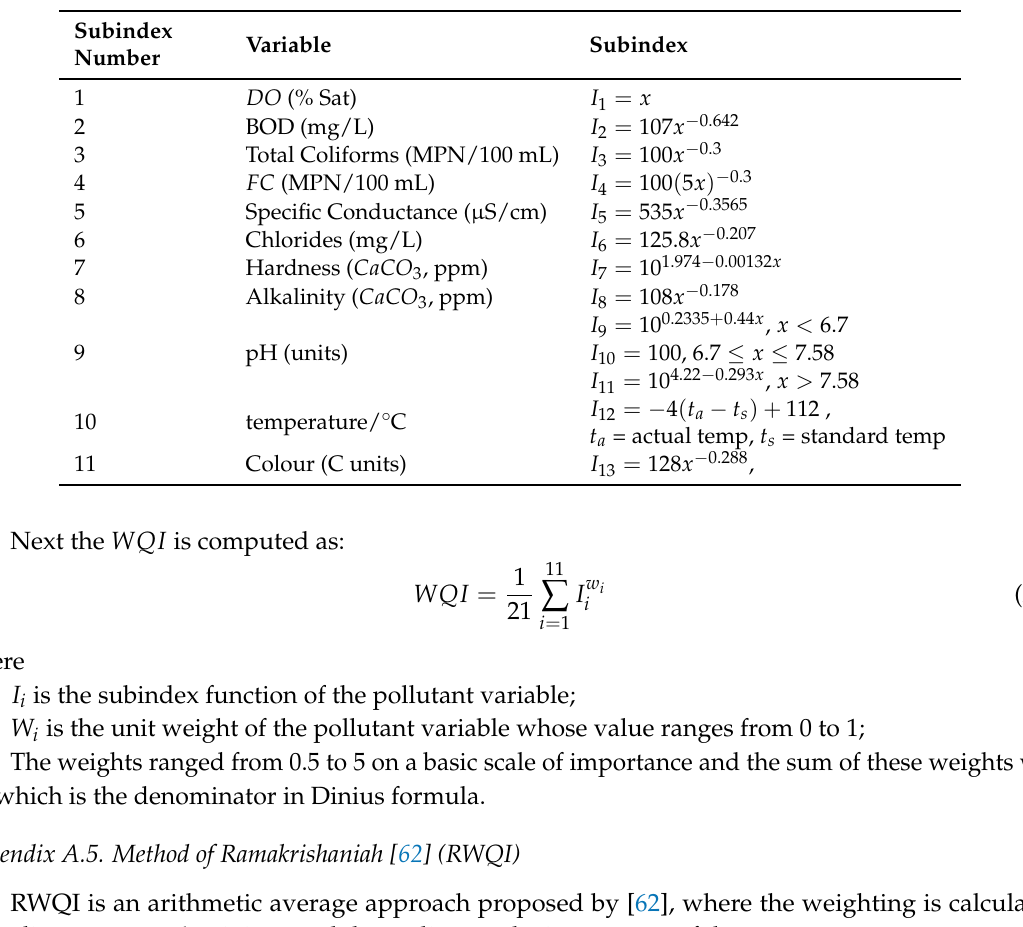
Table A3. Subindex Functions of Dinius’